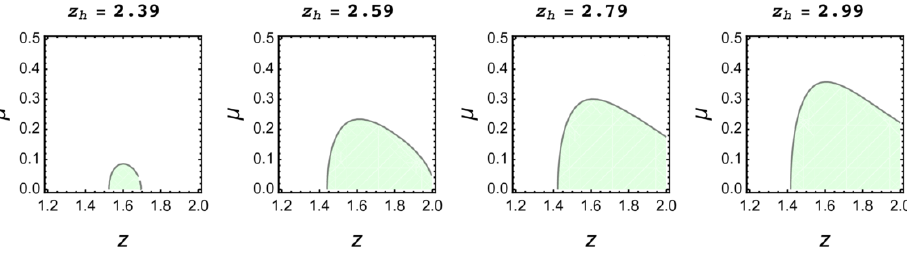
Figure 38 . Contour plots for DW iso near zero